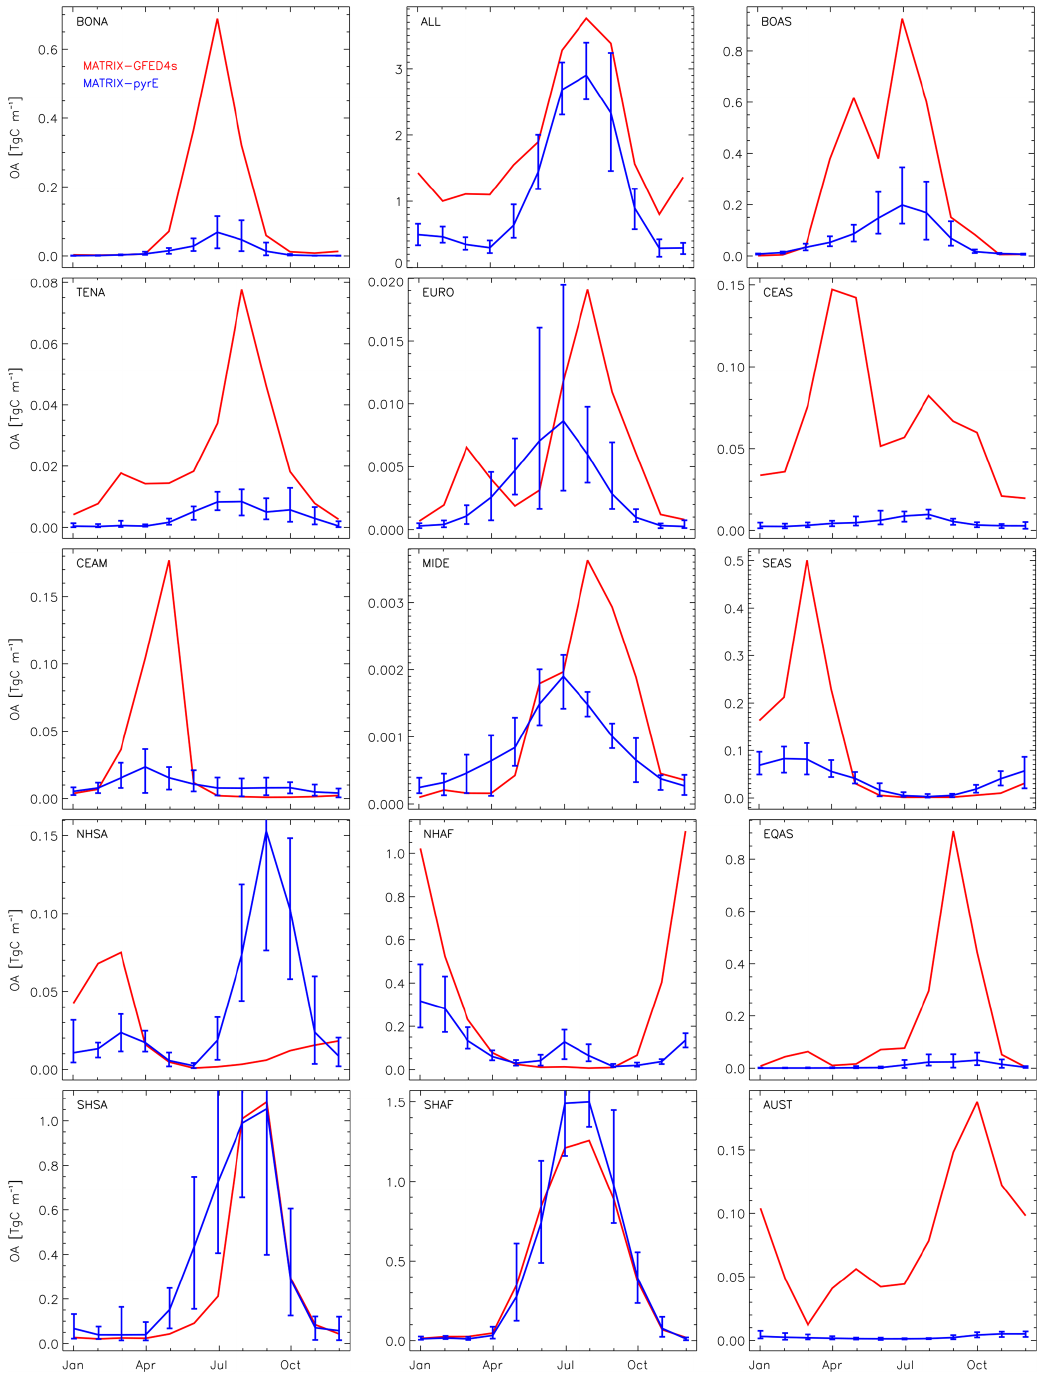
Figure A4. Seasonality of total fire organic aerosol (OA) emissions simulated (blue) and reported by GFED4s (red) in all GFED regions. Error bars represent the 10-year range in the simulations. Note the different scales in each